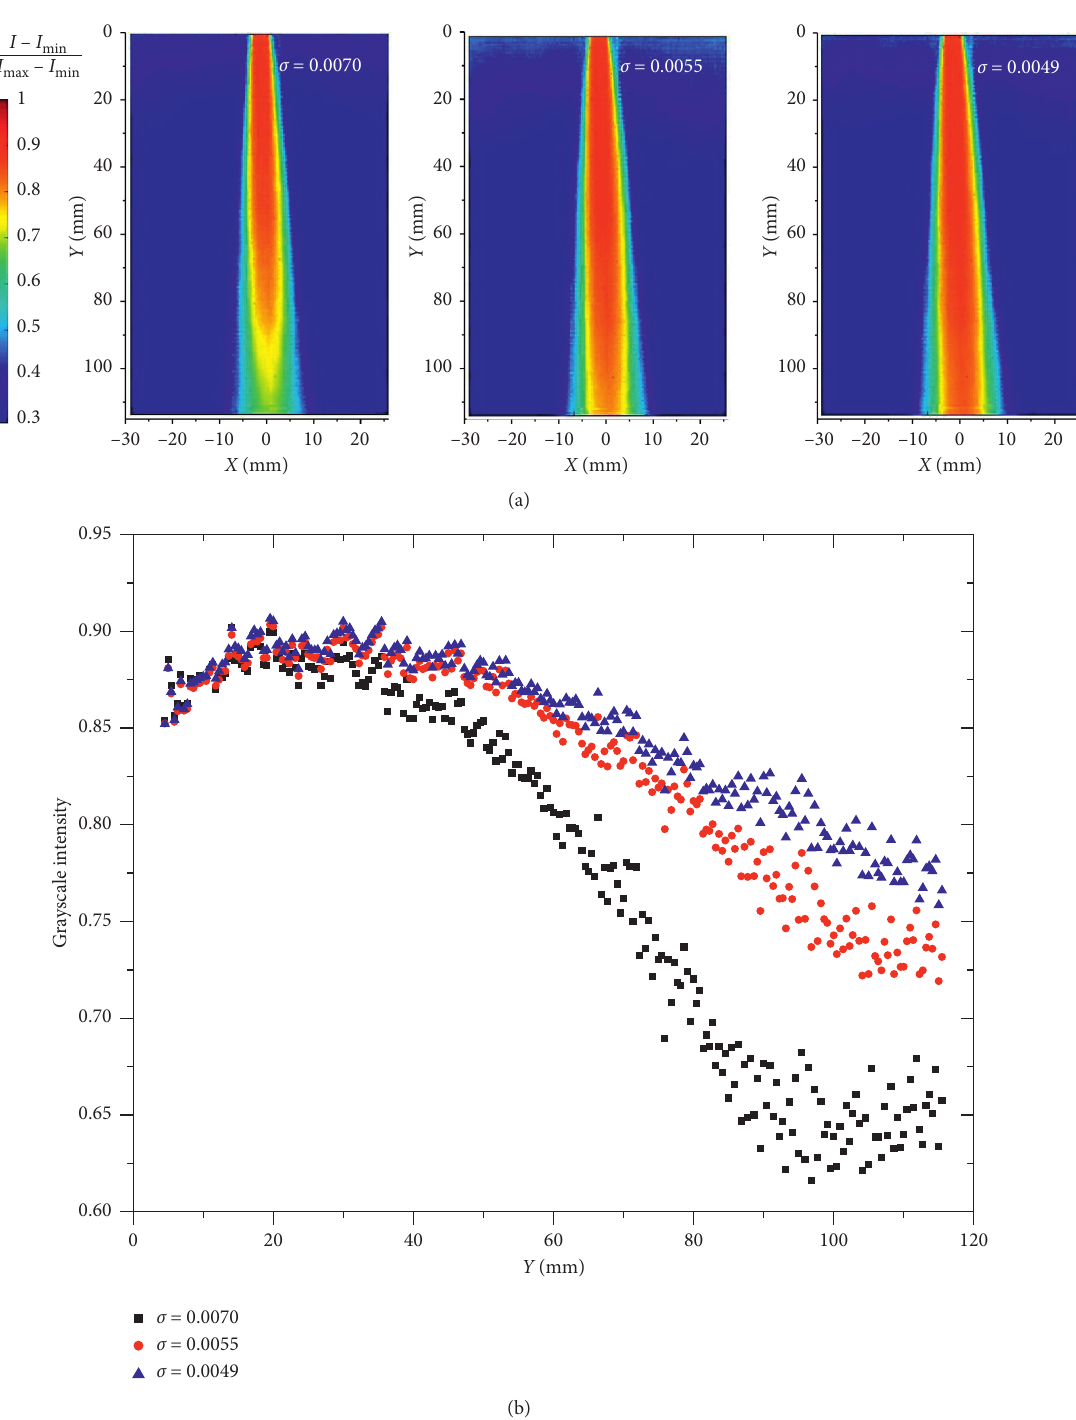
Figure 8: Time-averaged grayscale distribution of cavitation image with different jet pressure (40 ° nozzle). (a) Contour of time-averaged grayscale. (b) Distribution of gray values on the central